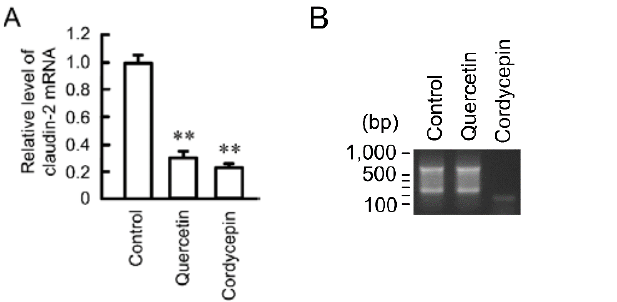
Figure 6. Effect of quercetin on polyadenylation. ( A ) A549 cells were incubated in the absence (control) and presence of 50 μM quercetin or 10 μM cordycepin for 6 h. The expression level of mRNA was quantified by real-time PCR using primers for claudin-2 and β-actin, and was represented relative to values at control; ( B ) After reverse transcription using Olig-dT-3 sites adaptor primer, 3′-RACE PCR was carried out. The PCR products were visualized with ethidium bromide. n = 3–4. ** p < 0.01 is significantly different from control.